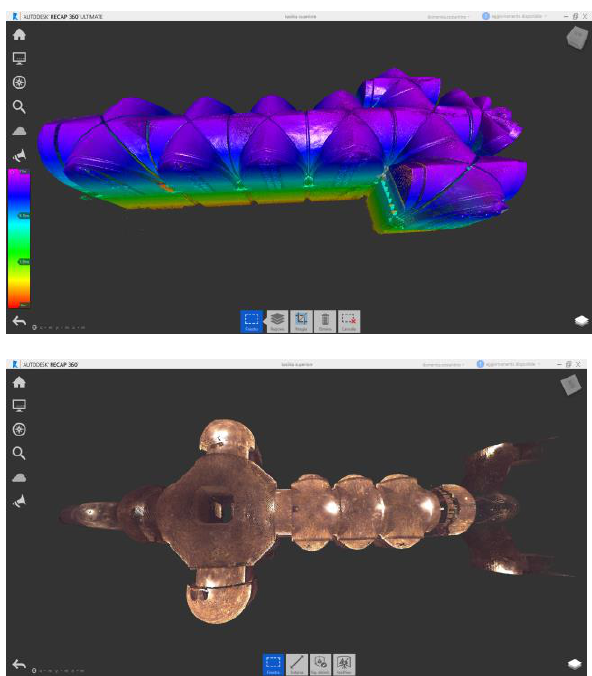
Figure 16. Point cloud of the upper basilica (up) and of Crypt (down) in RECAP 360